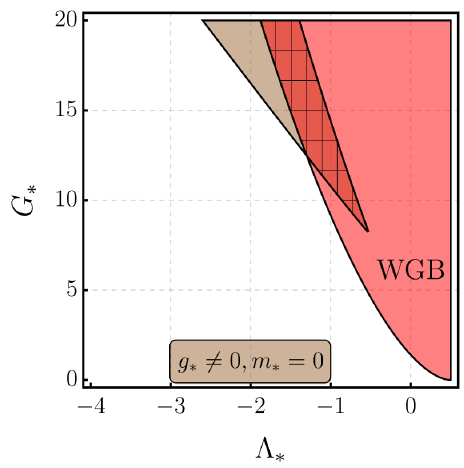
Figure 5 . We show in brown the region where the interacting, massless fixed point exists at the same time the mass corresponds to a relevant direction. The region excluded by the weak-gravity bound is shown in red. In comparison to figure 3, the lower/left boundary of the brown region is the same, but the upper/right is shifted, because the critical exponent associated with the mass, eq. (3.16), receives a contribution from g = 0 which is absent at the fixed point in figure ∗ 6